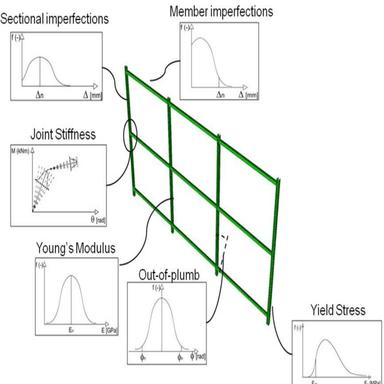
Random variables in a rack frame.